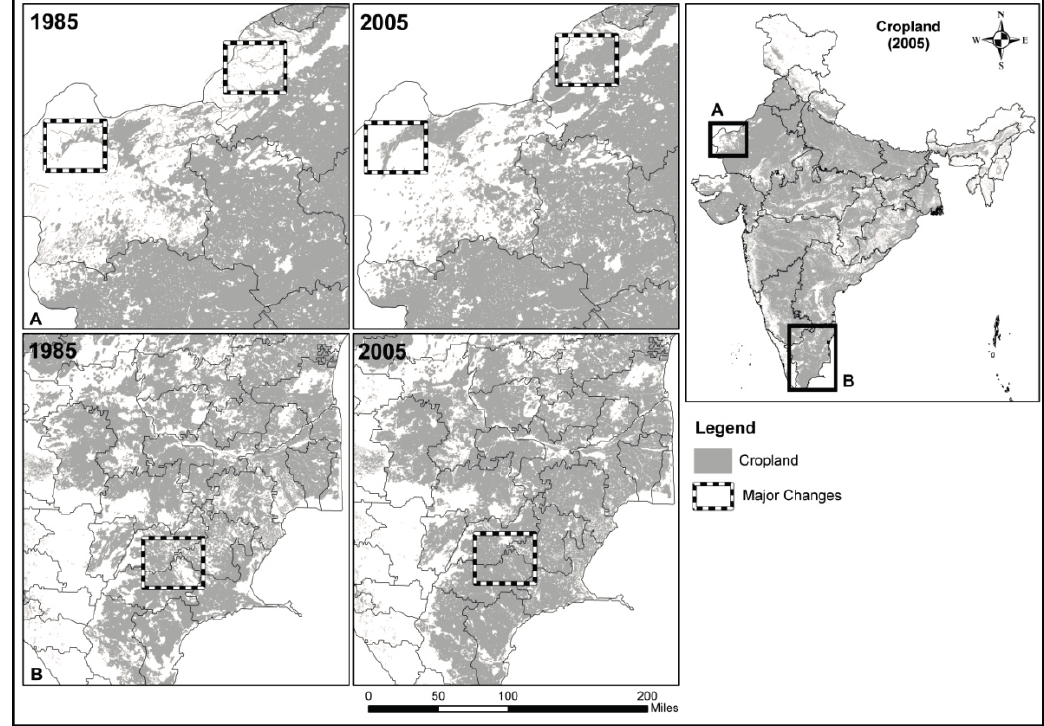
Figure 7. Increase in crop land during 1985 to 2005 in western India and east coast of south